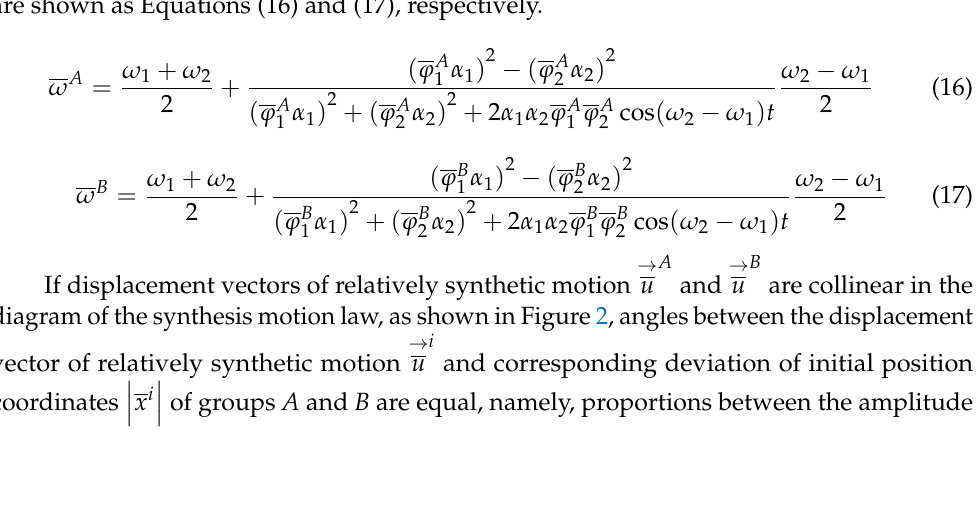
It can be seen that the magnitude of this amplitude varies periodically with